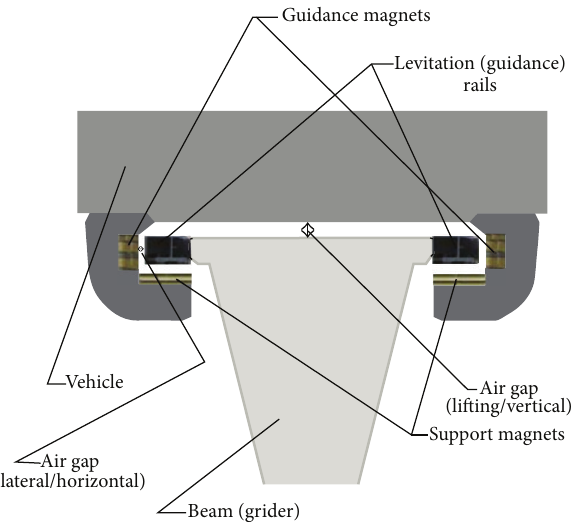
Figure 14: Schematic diagram of EMS maglev system.